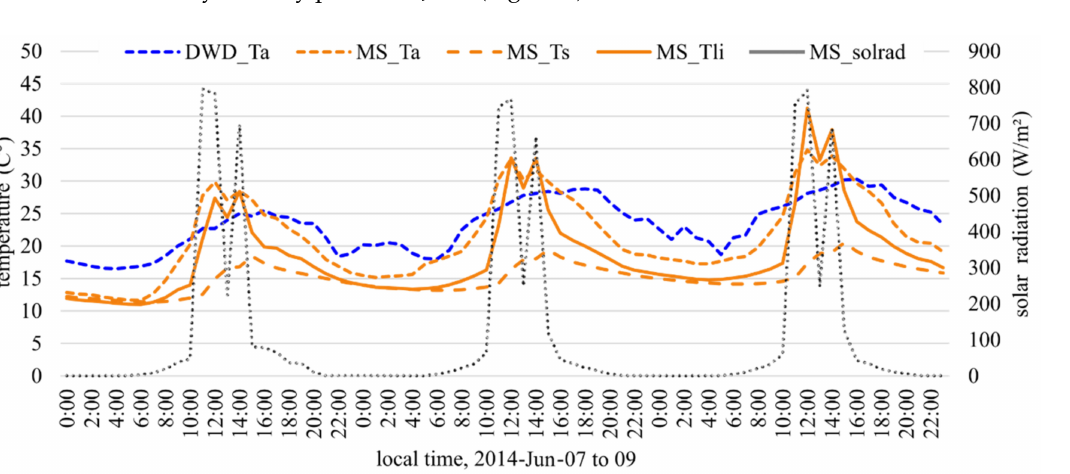
Figure 4. Diurnal radiation and temperature pattern during clear sky conditions over three days in June 2014. MS refers to the Medium Station at the “small clearing”, with Ta = air temperature (50 cm), Ts = soil temperature ( − 5 cm), Tli = near-surface temperature, solrad = solar radiation, and DWD_Ta air temperature (2 m) of the nearby official weather